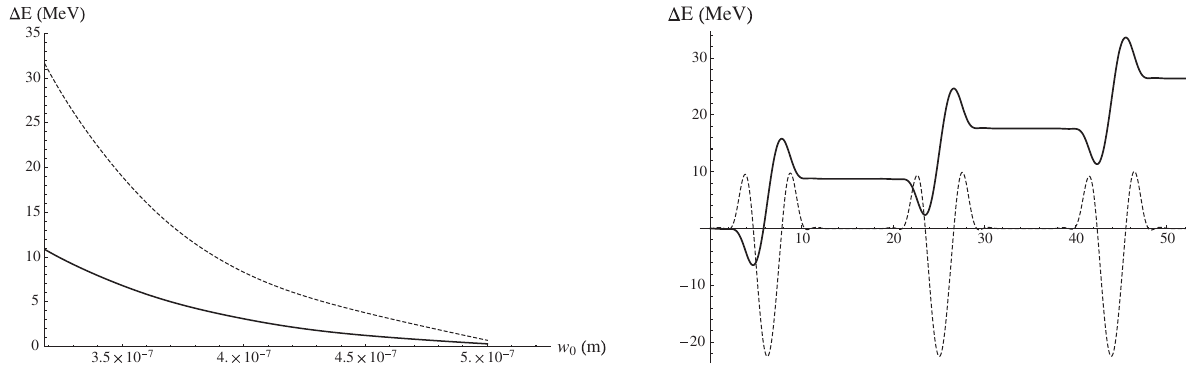
FIG. 2. Net energy gain Δ E in MeV versus w 0 for a 100 MeV electron injected into the focus of a 1 TW (black continuous line) and 10 TW (dashed line) Gaussian beam ( λ ¼ 1 μ m). The smallest value w 0 ¼ λ = π corresponds to the limit of the perturbative expansion of the fields ( ϵ ¼ 1 ). The largest value corresponds to w 0 ¼ λ = 2 .